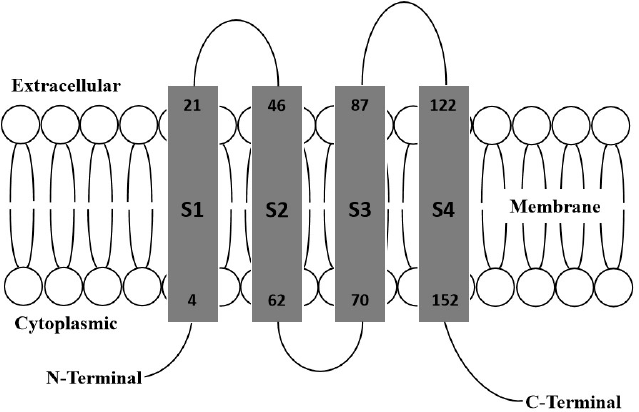
Figure 2. Secondary structure of soybean GmPLMT predicted by NetSurfP-2.